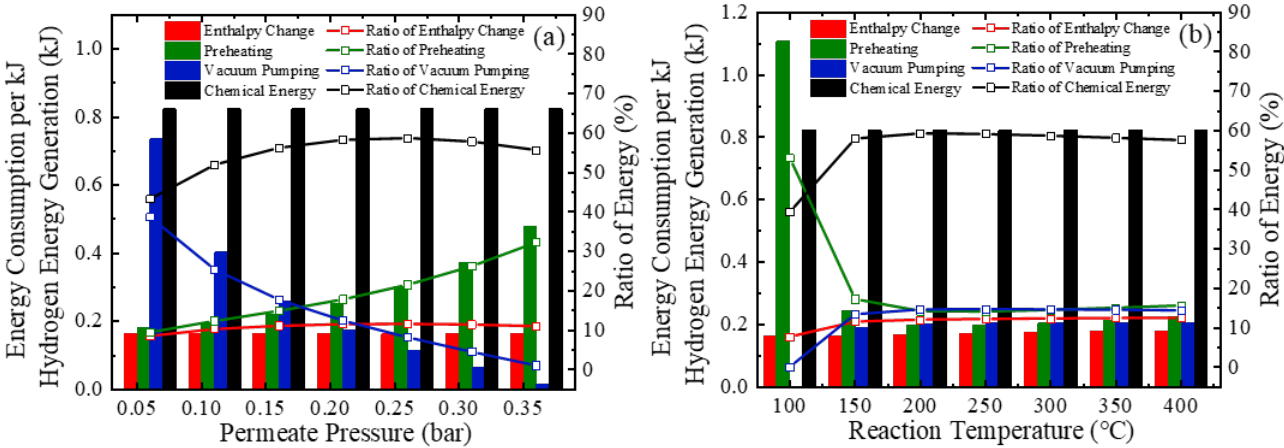
Figure 6. Energy consumption per kJ hydrogen energy generated ( η s → e = 15%) under ( a ) different permeate pressures (reaction temperature of 150 °C) and ( b ) different reaction temperatures (permeate pressure of 0.2 bar).